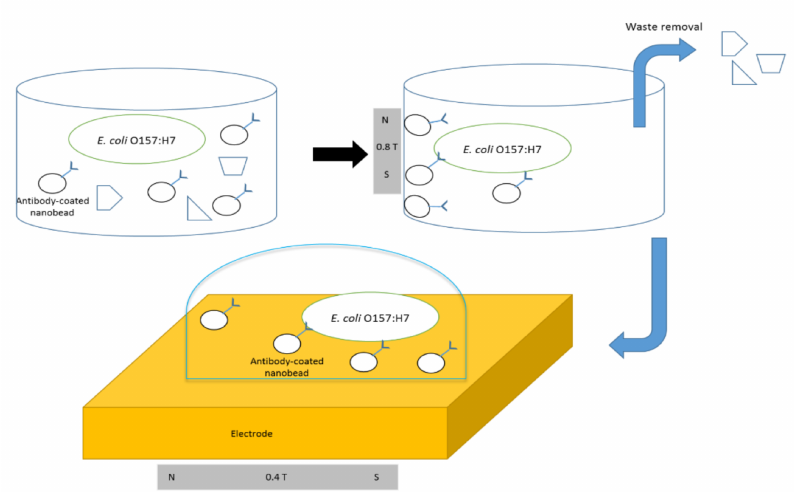
Figure 7. Architecture illustration of antibody-covered nanobeads and low concentration detect of E. coli using a magnetic field procedure. Reprinted from Ref.